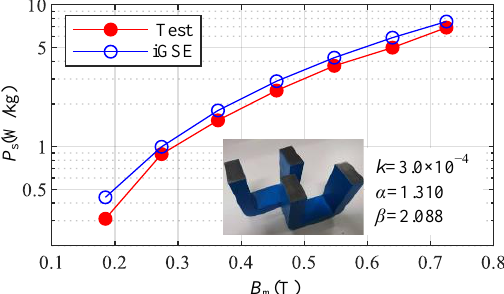
Figure 6. Comparison of experimental and calculated losses of the main core ( D h = 0.5, D s = 0). The experiment is carried out with the core sample, and the calculated value and the measured value are compared in Figure 6, verifying the effectiveness of the model.